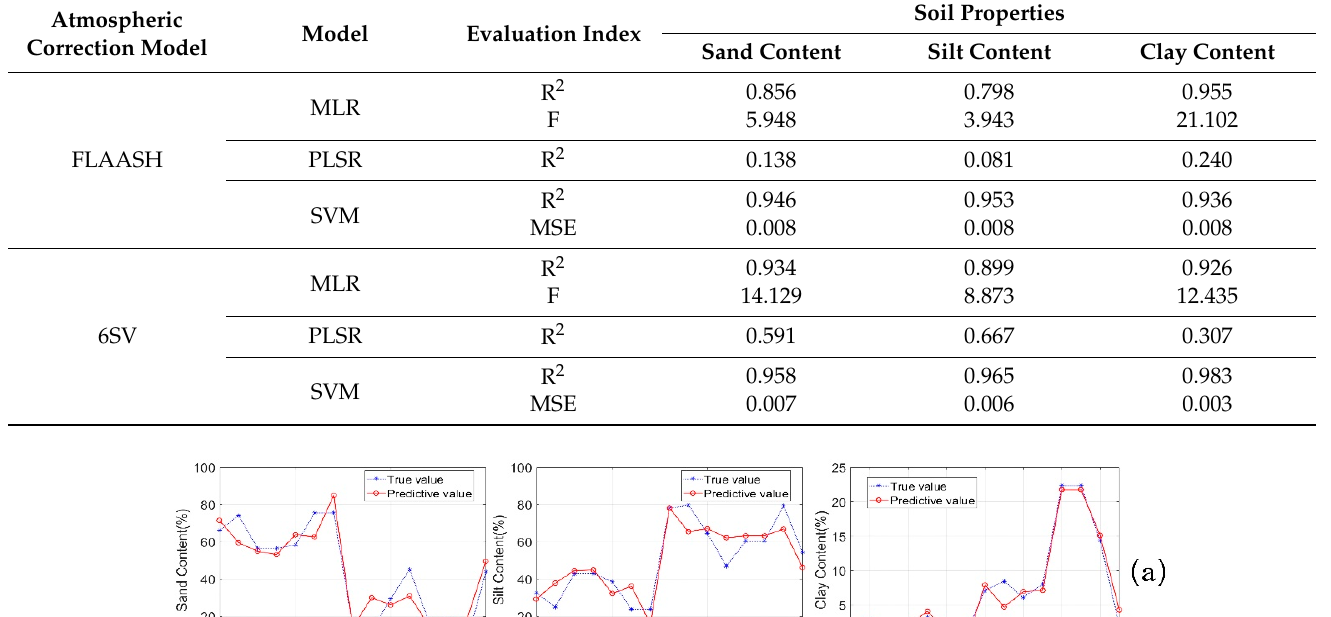
Table 5. Prediction accuracy of MLR, PLSR, and SVM models.